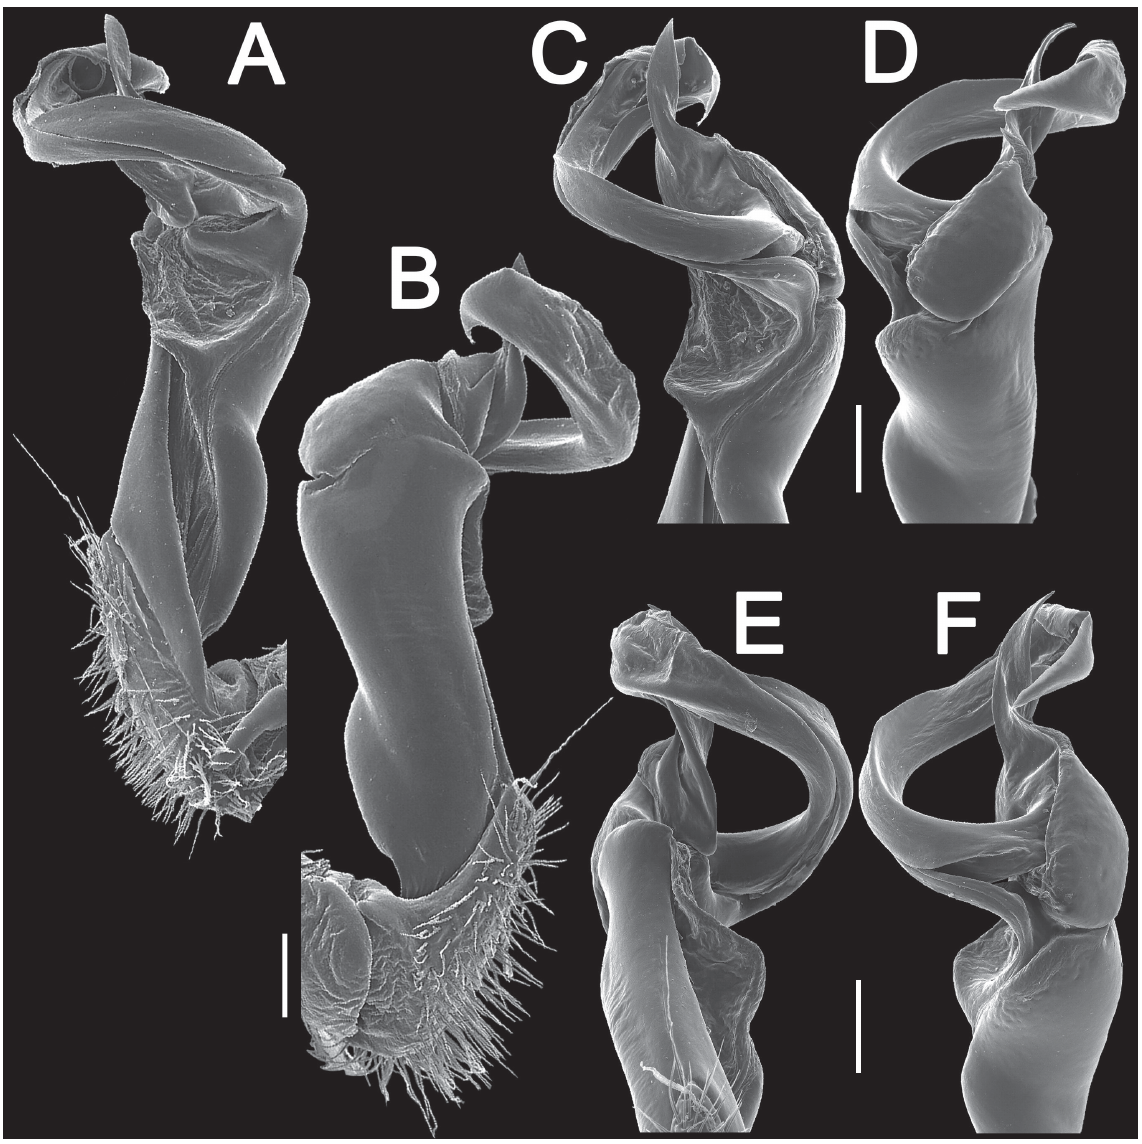
Fig. 14. Tylopus acuminatus sp. nov., holotype, ♂, right gonopod. A–B . Mesal and lateral views, respectively. C–F . Distal part, sublateral, submesal, subcaudal and suboral views, respectively. Scale bars = 0.2